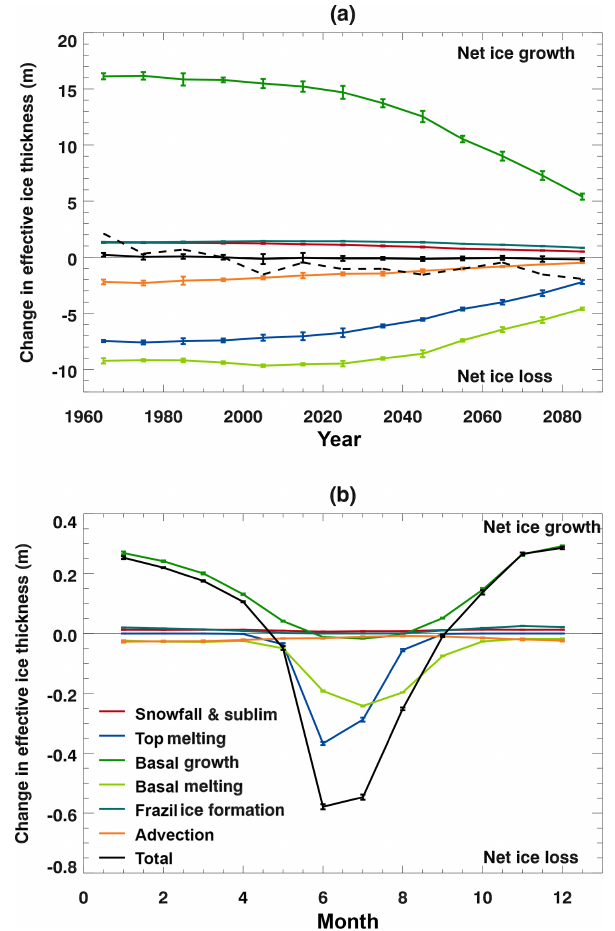
Figure 4. Components of the sea ice volume budget as defined in Sect. 3.1 for the HadGEM2-ES Hist + RCP8.5 integrations, aver- aged over the region defined in Fig. 2. Values are ensemble means ± 1 standard deviation, and positive values correspond to net ice growth. (a) Decadal mean time series, with the dashed line showing the sum of the budget terms magnified by a factor of 10. (b) Sea- sonal cycle for the reference period